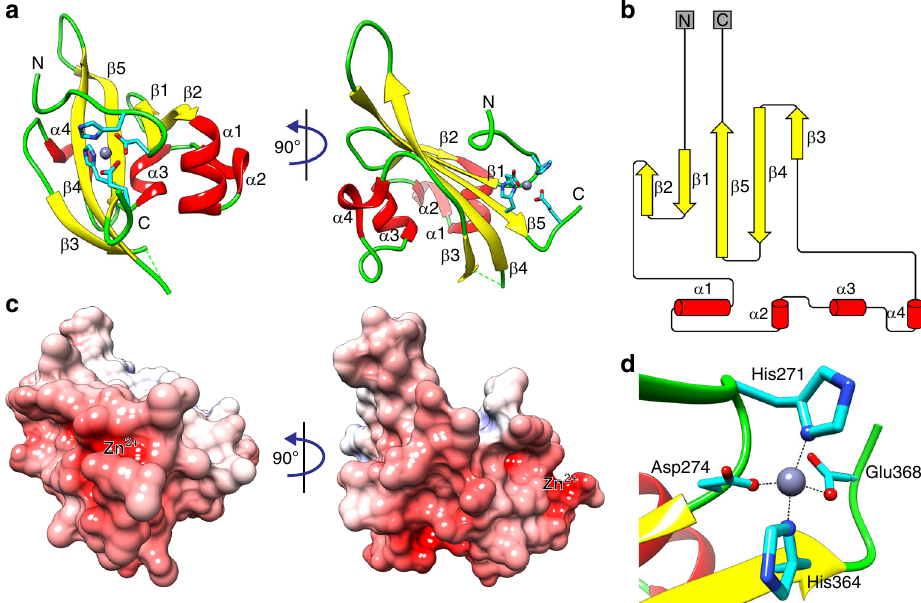
Fig. 3 Crystal structure of S. aureus WalK-PAS FULL . a Cartoon representation of the crystal structure of WalK-PAS FULL . The α -helices are coloured red, β - strands yellow and loops green. The bound Zn 2 + is shown as a grey sphere and its coordinating residues as cyan sticks. The N- and C-terminus of the structure are labelled. b Sequence and crystal structure-based secondary structure of WalK-PAS FULL generated by Pro-origami 66 . α -Helices are shown as red cylinders and β -strands as yellow arrows. c Surface electrostatic potential of WalK-PAS FULL shown in the same orientation as in a . Positive and negative potentials are shown in blue and red, respectively, coloured continuously between – 10 and 10 kT e − 1 . Surface electrostatic potential was calculated using APBS 67 ; the calculation included the Zn 2 + ion. d The Zn 2 + -binding site of WalK-PAS FULL . Metal-coordinating residues are shown as cyan sticks, with the atoms contributing to the interactions as spheres. The coordinating bonds are illustrated with black dashed